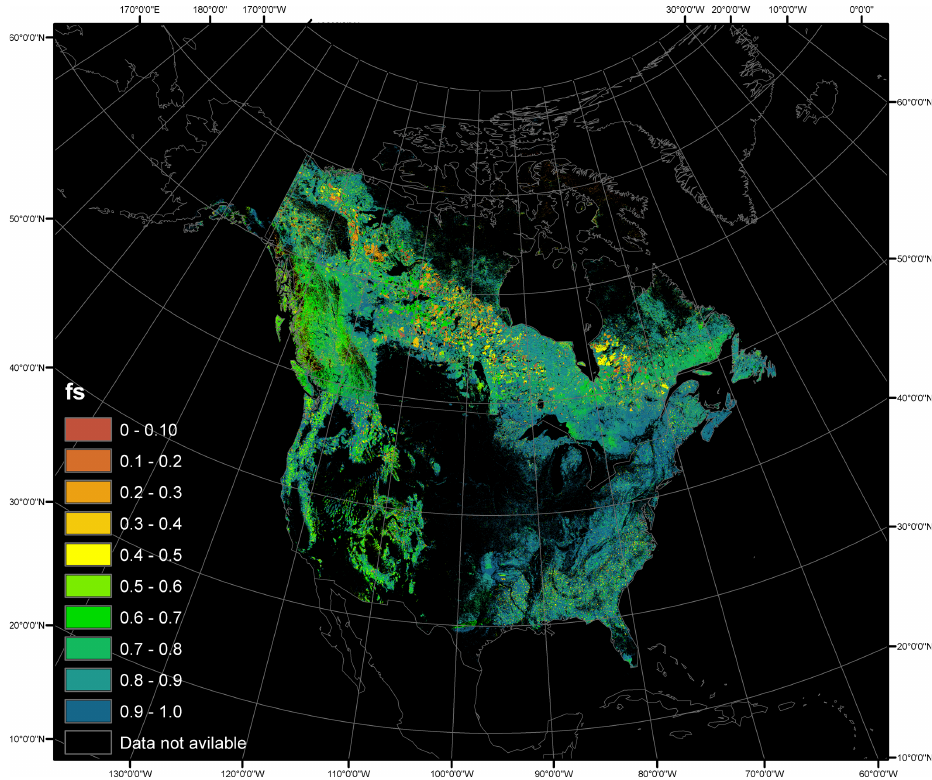
Fig. 2. The distribution of f s for North America where forest stand age information is available. f s is defined in Eq. (5) as the age varied NPP calculated from Eq. (4), normalized by the maximum NPP determined by climate condition of a grid cell. f s was calculated at a spatial resolution of 1000 meters, and mapped using an Albers conic equal-area